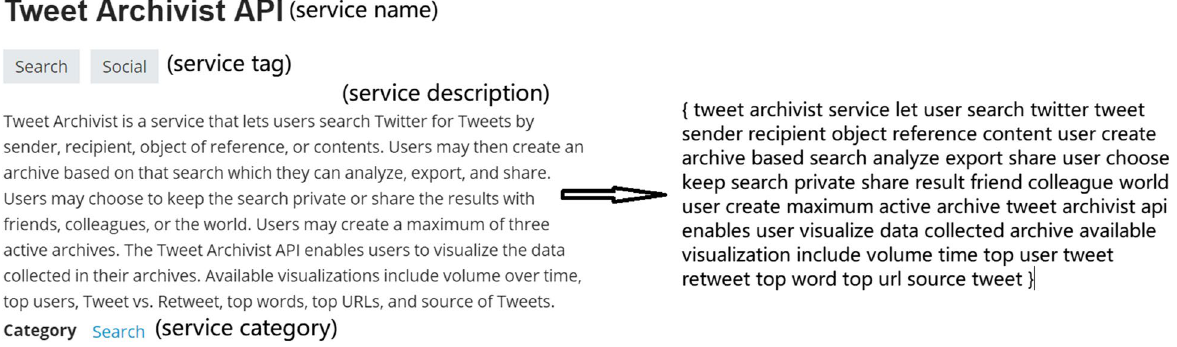
Fig. 3 Pipeline process for cloud service/Web API clustering